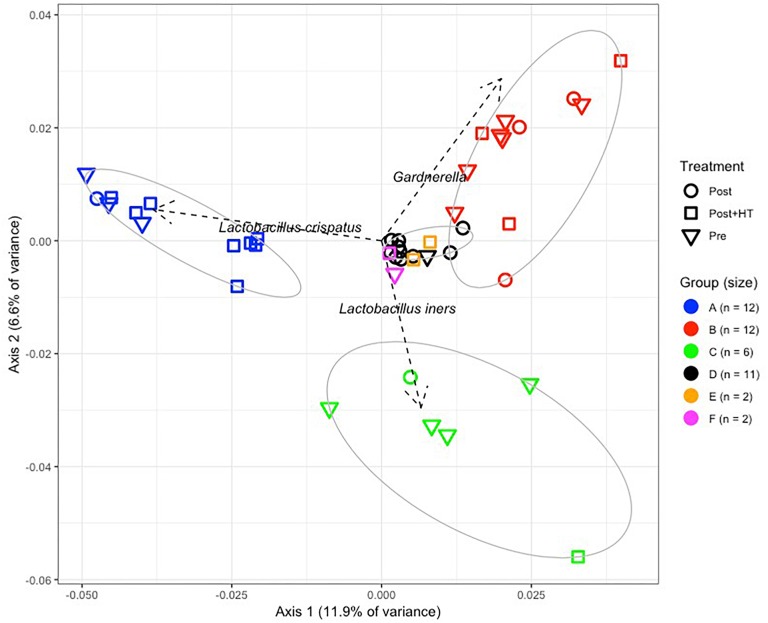
Principle components analysis of vaginal bacterial communities found in 45 women who were either premenopausal, postmenopausal, or postmenopausal and receiving hormone replacement therapy.